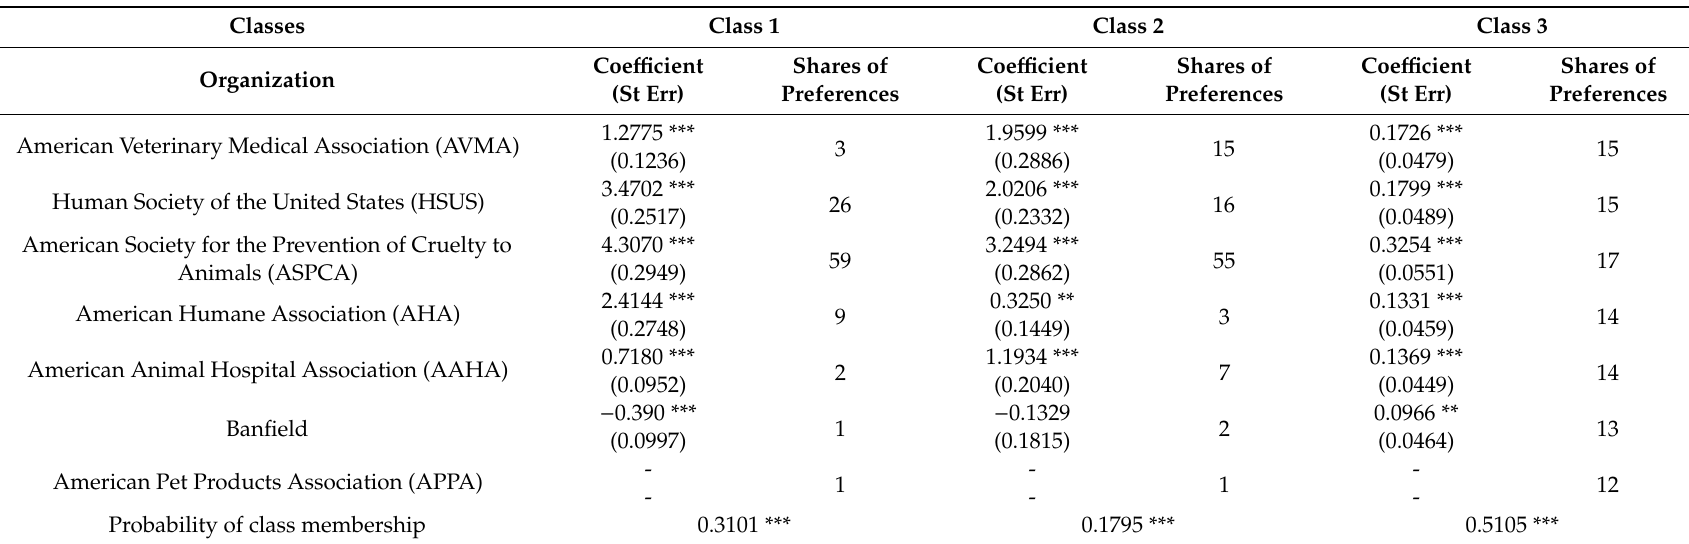
Table 8. Latent Class Model